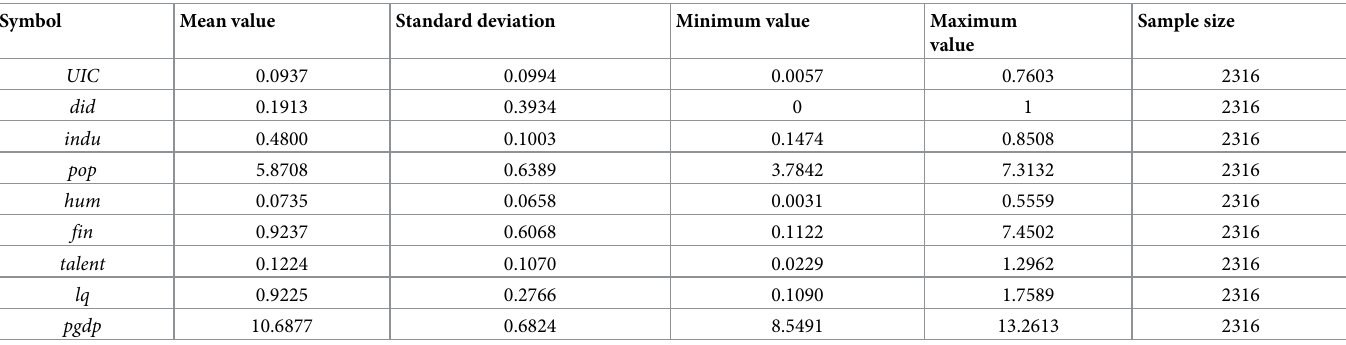
Table 3. Descriptive